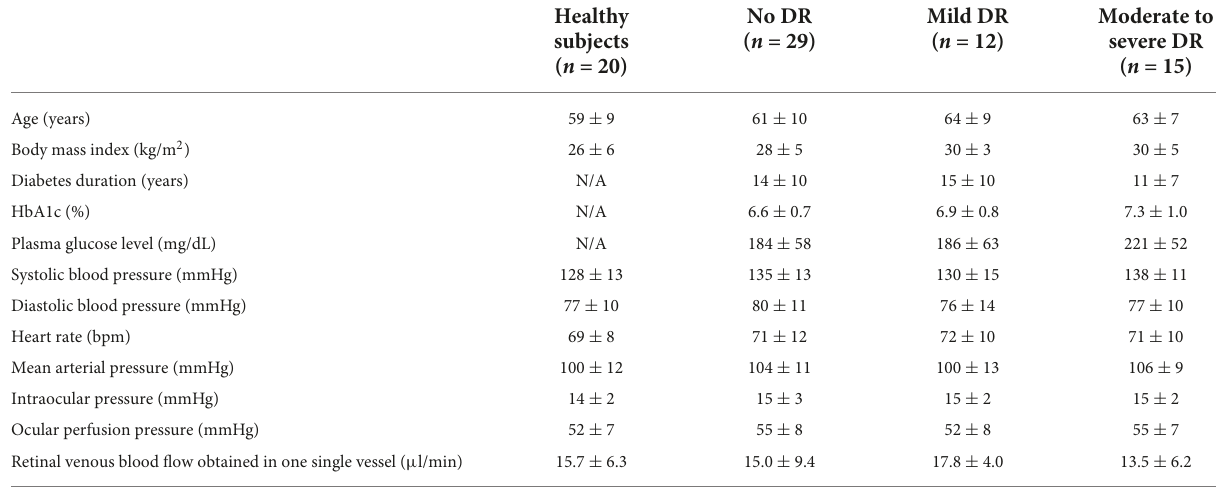
TABLE 1 Baseline characteristics of the four study